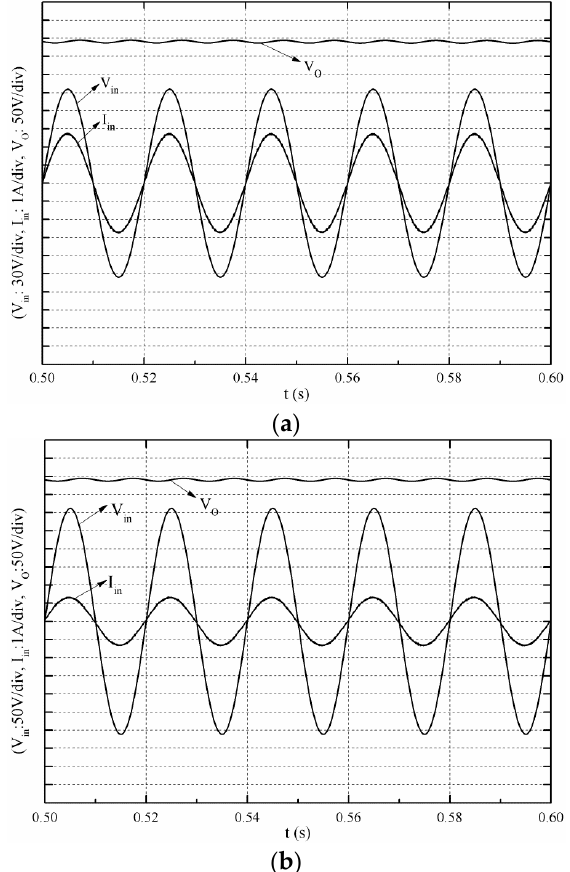
Figure 9. PFC input voltage, current, and output voltage with J-A model consideration; ( a ) V in = 110 V; and ( b ) V in = 220